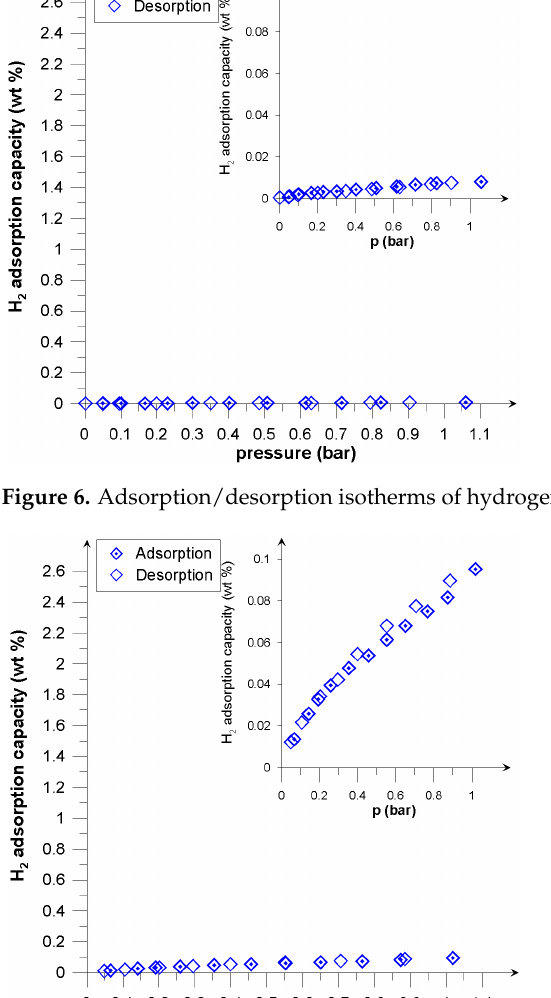
Figure 5. Adsorption/desorption isotherms of hydrogen on Picazine K at 77 K.